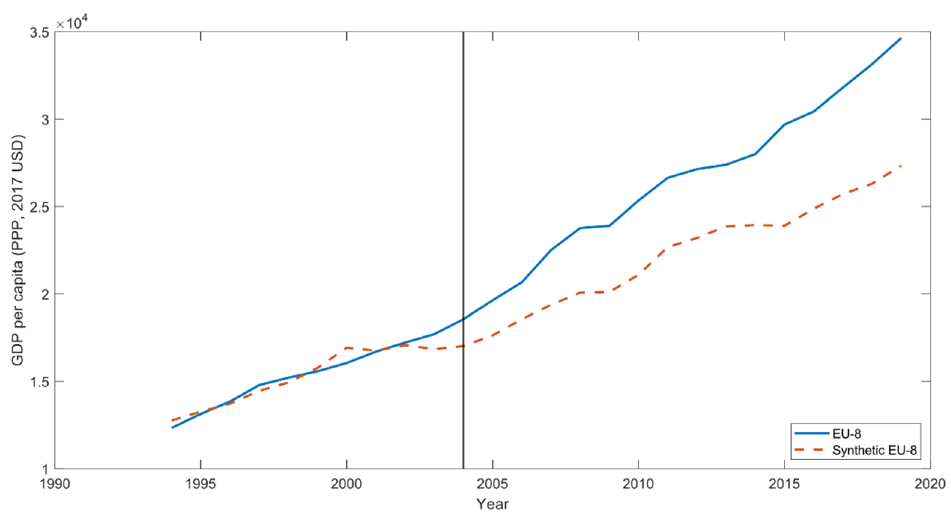
Figure 5. Sensitivity analysis: EU-8 versus synthetic EU-8.